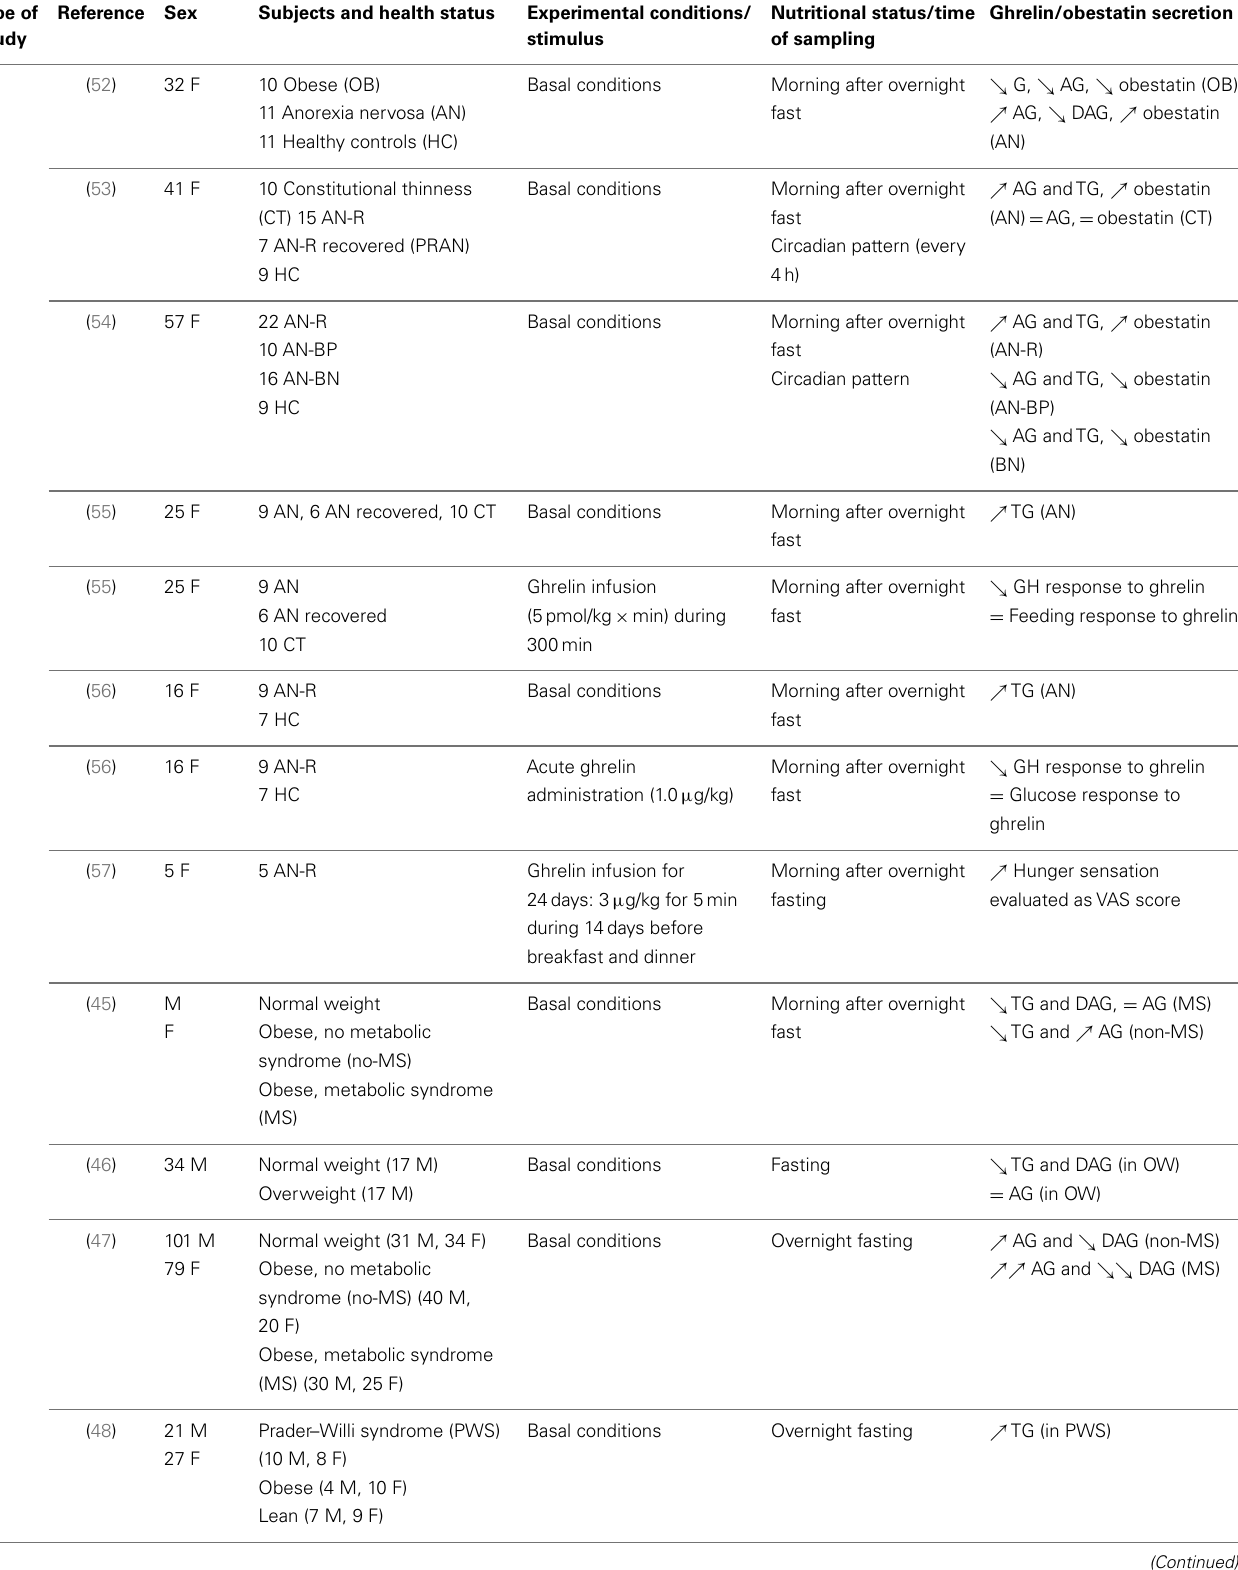
Table 2 | Regulation of plasma ghrelin/obestatin concentrations in different human pathologies, health and nutritional status, and experimental conditions